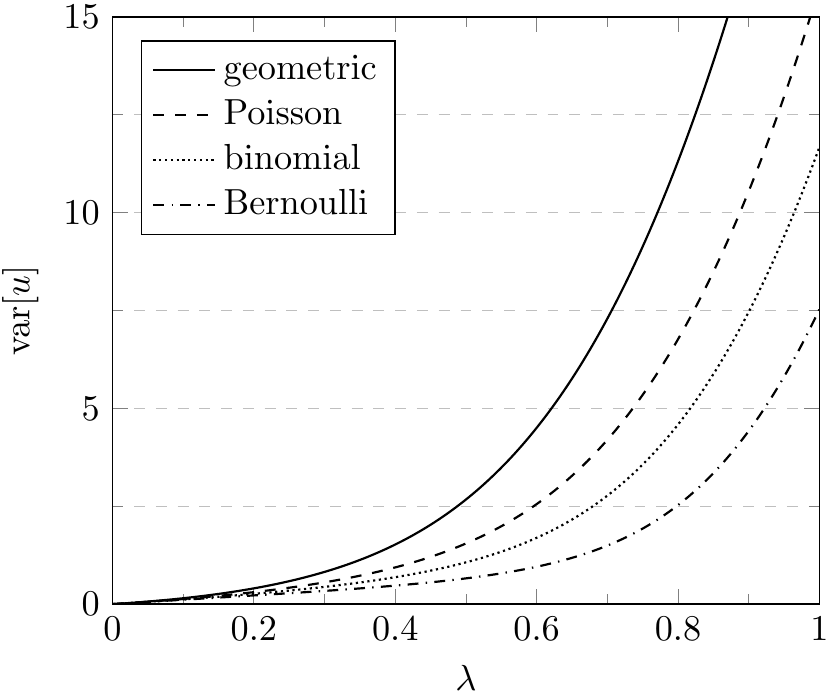
Figure 10. Variance of the system content var [ u ] versus λ for geometric service times with µ = 0.75, σ = 0.1 and various distributions for the number of arrivals per